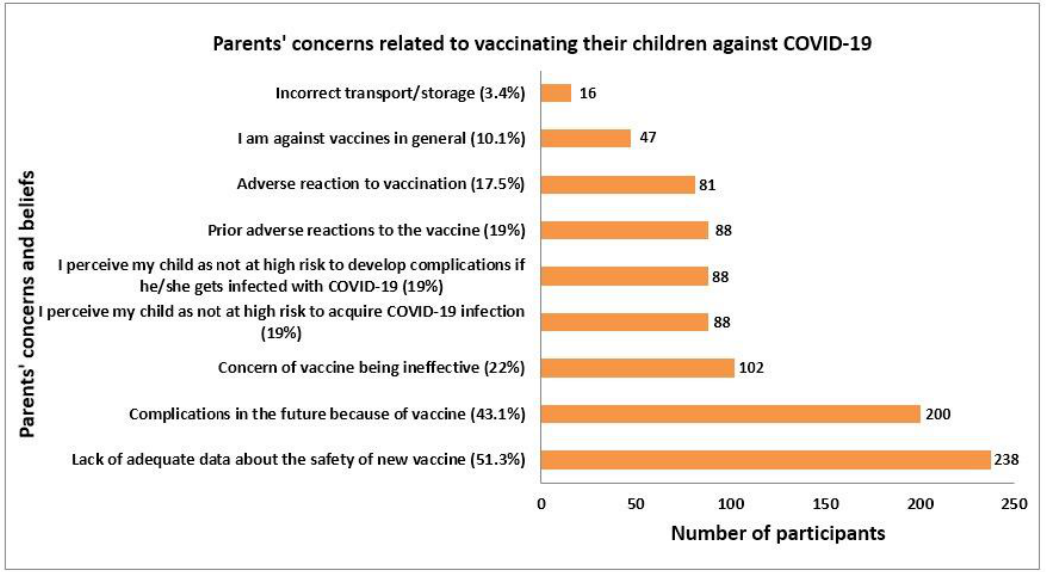
Figure 2. Parent’s concerns related to vaccinating their children against COVID -19.